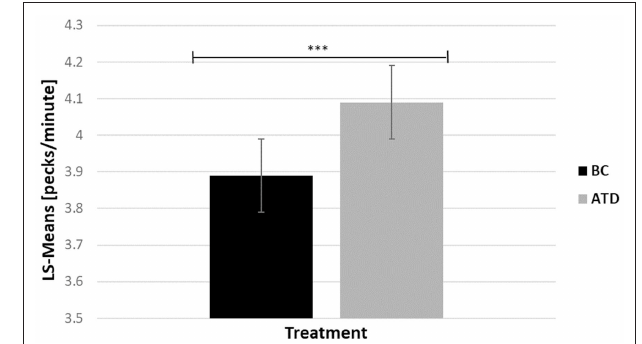
FIGURE 4 | Least square-means (pecks/minute) of feather pecking behavior in acute tryptophan depletion (ATD)—treated birds and in Balanced Control (BC)—treated birds. Statistically significant results are indicated as *** P < 0.001.